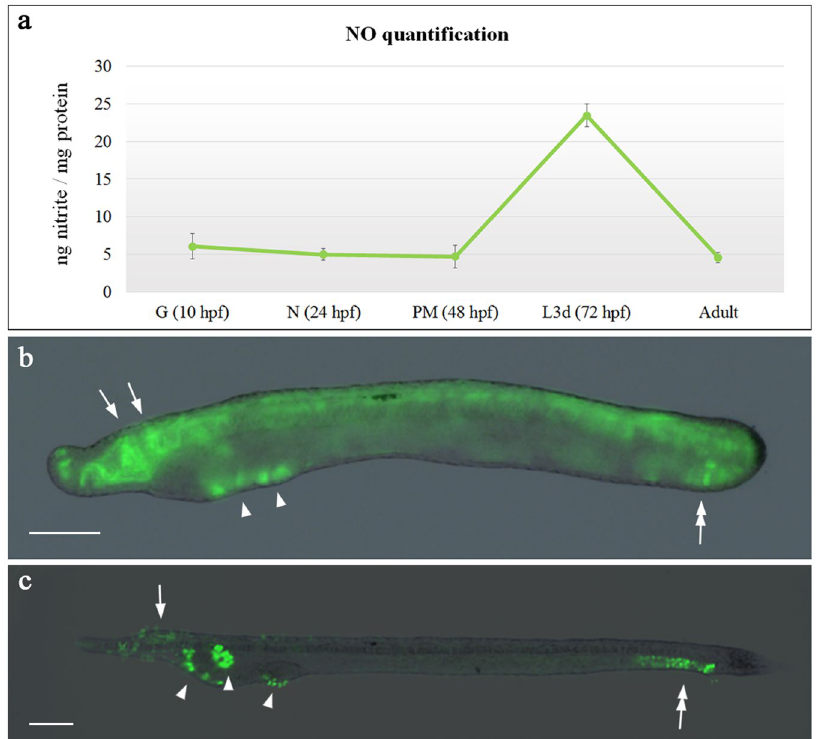
Figure 3. Nitrite quantification and nitric oxide detection in amphioxus embryos. The graph ( a ) shows the nitrite quantification during embryonic development and in adult obtained by Griess assay, the results are expressed as nmol of nitrite/mg of proteins. Nitric oxide localization by DAF-FM-DA at ( b ) 48 hpf and ( c ) 72 hpf. Arrows indicate nervous system; arrowheads show pharyngeal area, mouth and gill slits; tandem arrows indicate hindgut. Embryos orientation: anterior to the left, dorsal to the top. Scale bars: 50 μ